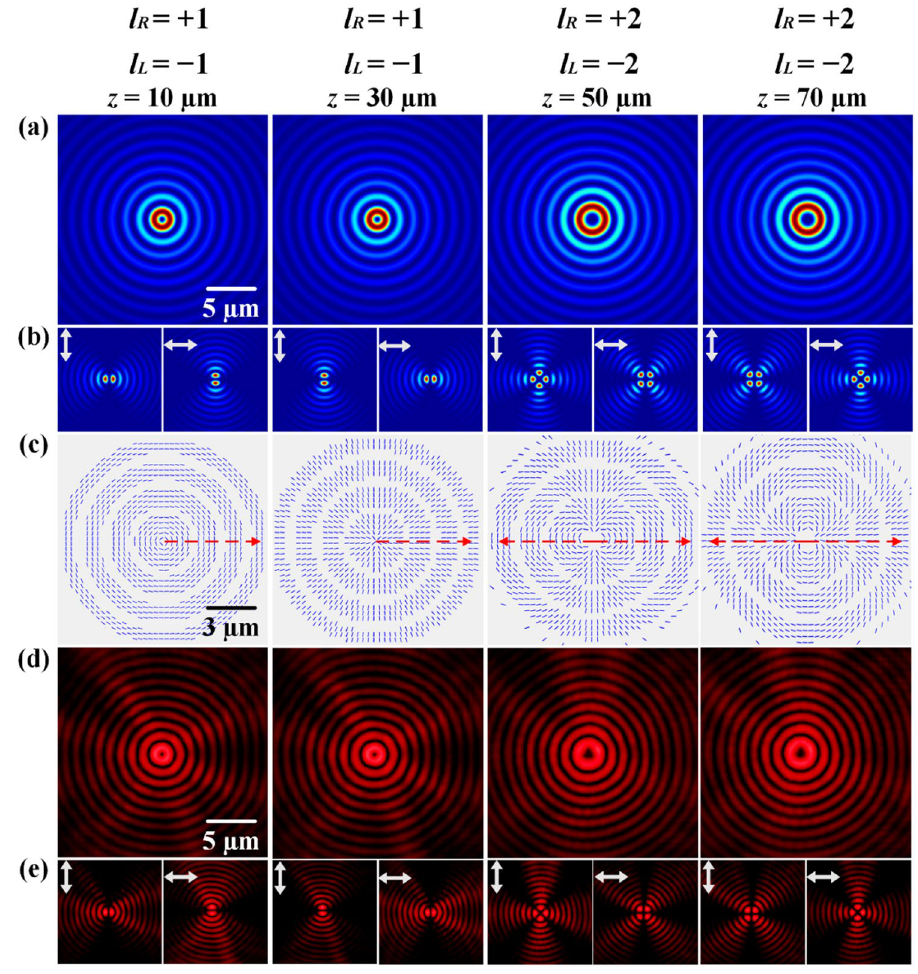
Figure 3. ( a ) The first category of vector vortex beam with the variation of polarization mode in the order of (TE → TM → TE → TM) with m = {1, 1, 2, 2} and n = 0. ( a ) Simulated beam intensity distributions without polarization analyzer at different propagation distances. ( b ) The corresponding intensity distributions analyzed with vertical or horizontal linear polarizer. ( c ) Simulated polarization distributions at different propagation distances. ( d , e ) The corresponding measured beam intensity distributions. The detailed transition processes of both beam intensity and polarization distributions are shown in the supplementary